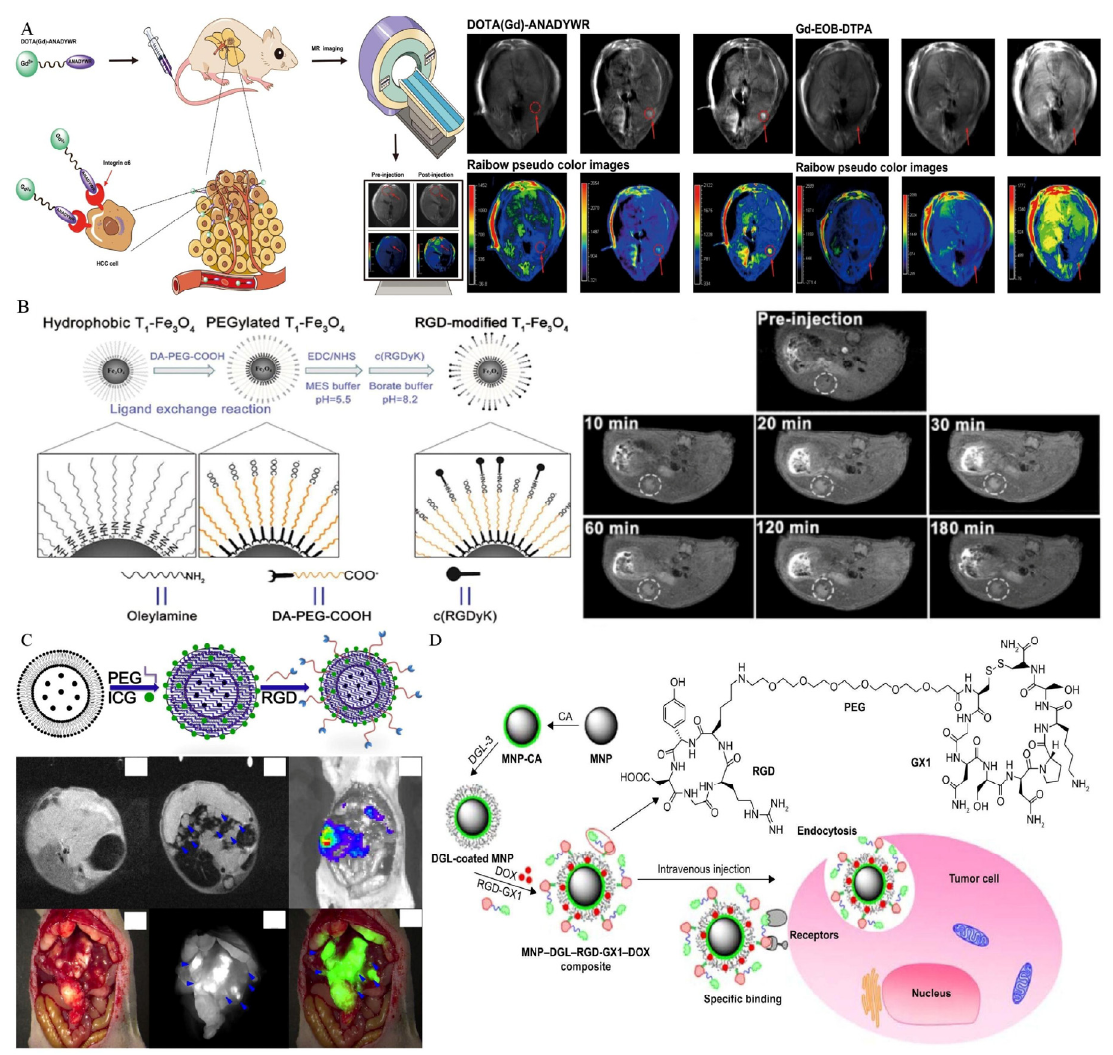
Figure 10. Research about various types of probes targeting Integrin. ( A ) Integrin α 6 targeted MR molecular imaging probe for HCC detection. Reproduced with permission Ref. [71]. Copyright 2021 Dovepress. ( B ) The synthesis of integrin α v β 3 active targeted T1 molecular imaging probe and MR images. Reproduced with permission Ref. [73]. Copyright 2016 Dovepress. ( C ) MR/NIRF dual modal imaging probe. Reproduced with permission Ref. [78]. Copyright 2017 Dovepress. ( D ) Schematic diagram of doxorubicin-loaded molecular imaging probes. Reproduced with permission Ref. [76]. Copyright 2017